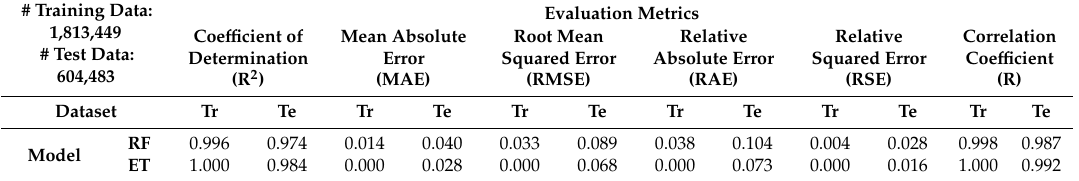
Table 3. The evaluation metrics on the model performance of RF and ET. A total of 1,813,449 training data and 603,483 test data were used. In dataset row, Tr and Te mean the training and test data, respectively.